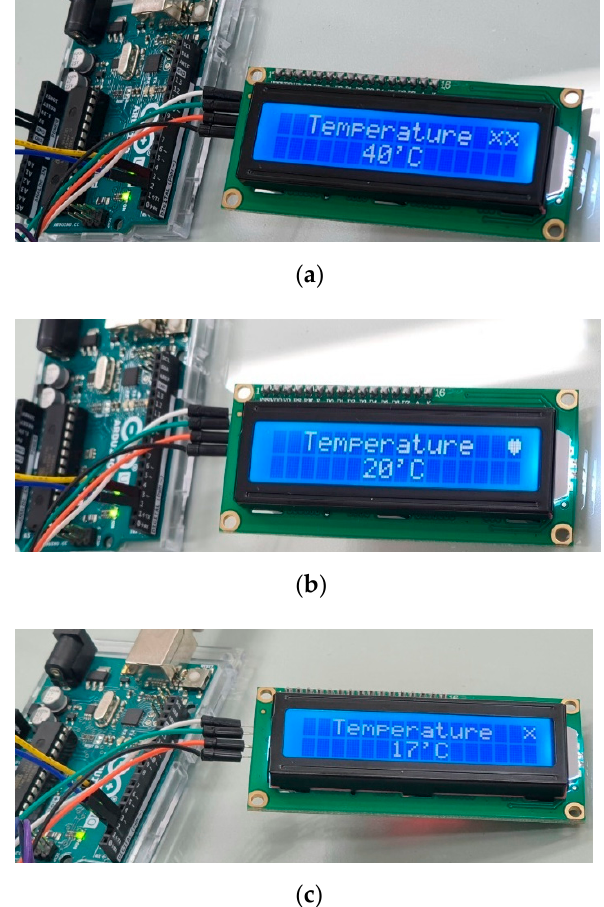
Figure 7. Meal temperature measurements by using an LCD display: ( a ) above (XX), ( b ) normal (heart), and ( c ) below (X) the reference temperature.